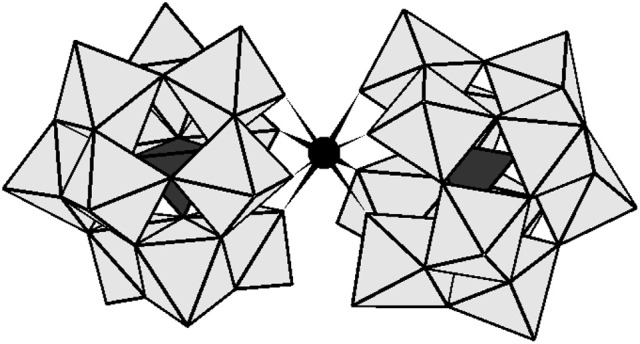
The polyhedral representation of [Ce(α-PW11O39)2]10− and [Zr(α-PW11O39)2]10−. The gray octahedral represents WO6 and the black tetrahedral stand for PO4. The black sphere represents ZrIV or CeIV.